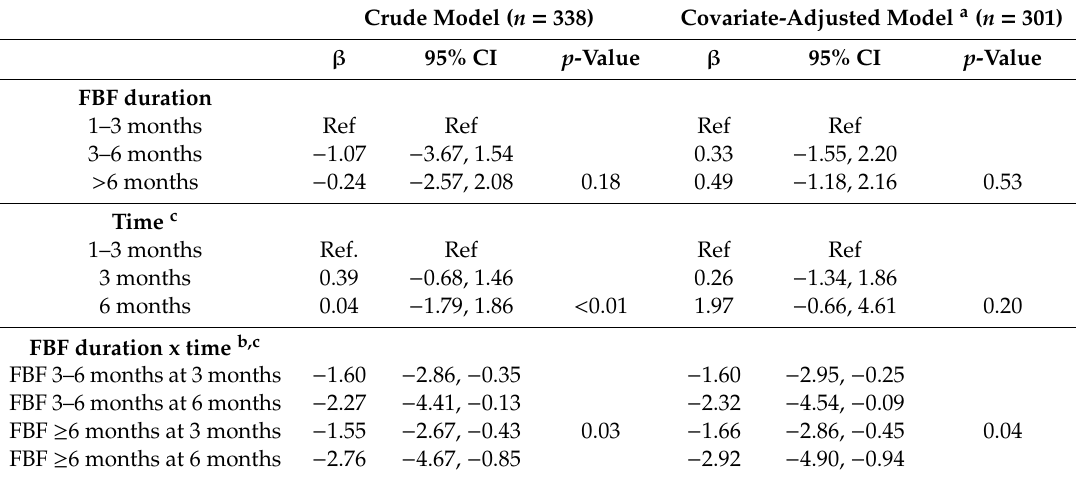
Table2. Association offull breastfeeding durationwith maternal postpartum weight retention measured from 1 to 6 months